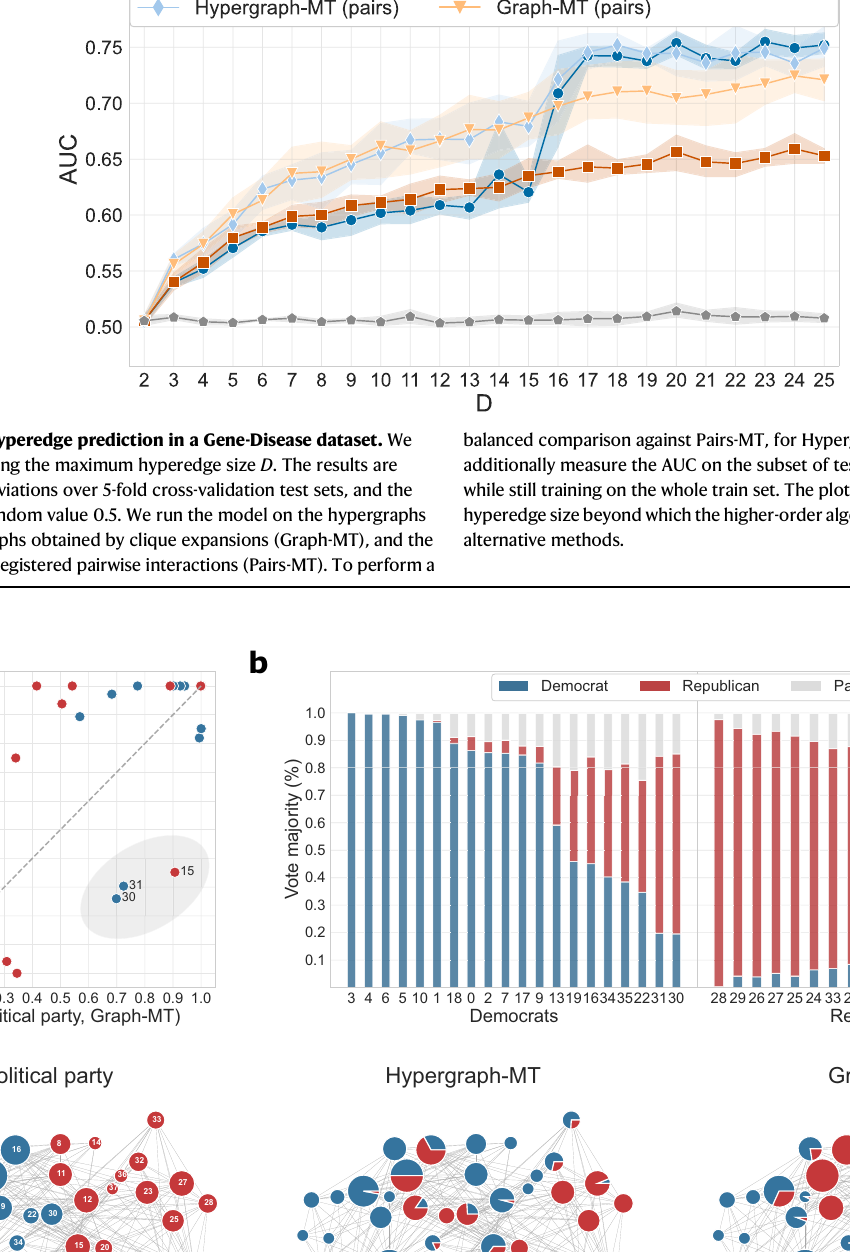
Fig. 3 | Inference of overlapping communities in a co-voting higher-order dataset of the U.S. Justices. a Point-by-point comparison between the cosine similarities (CS) obtained by Hypergraph-MT and Graph-MT. For each Justice (marker in the plot), we compute the CS between the partitions inferred by the methodsandthepoliticalpartyoftheJustices,i.e.,Democrat(blue)andRepublican (red). b Vote majority proportion of the hyperedges of each Justice. Every hyper- edge is colored based on the majority political party of the Justices involved in it,